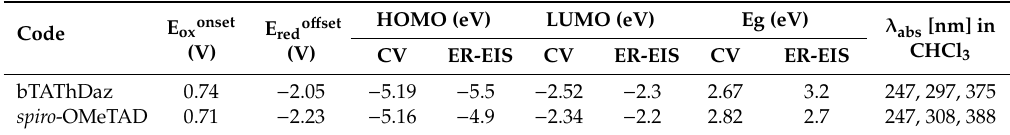
Table 1. Electrochemical (CV) in solution, energy-resolved electrochemical impedance spectroscopy (ER-EIS) in thin film and optical (UV-Vis) properties of imine and spiro -OMeTAD in solution.